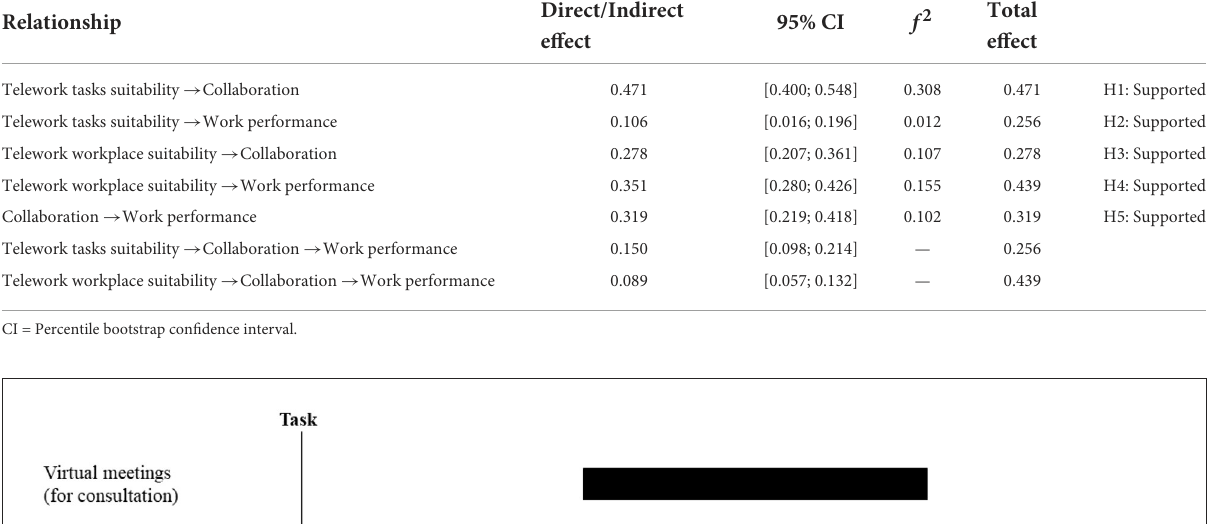
TABLE 4 Evaluation of the structural model. Relationship